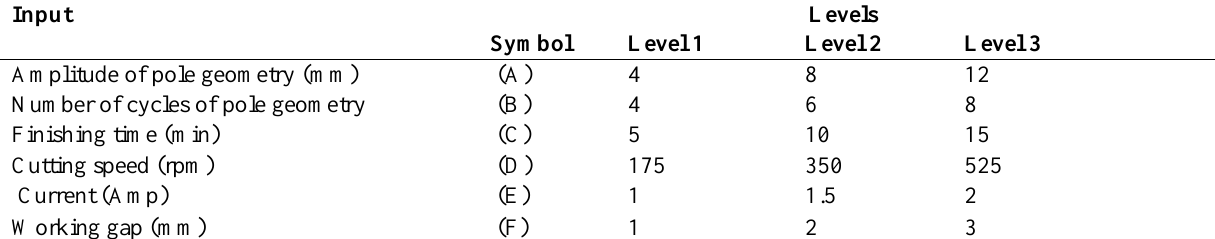
Input parameters for MAF